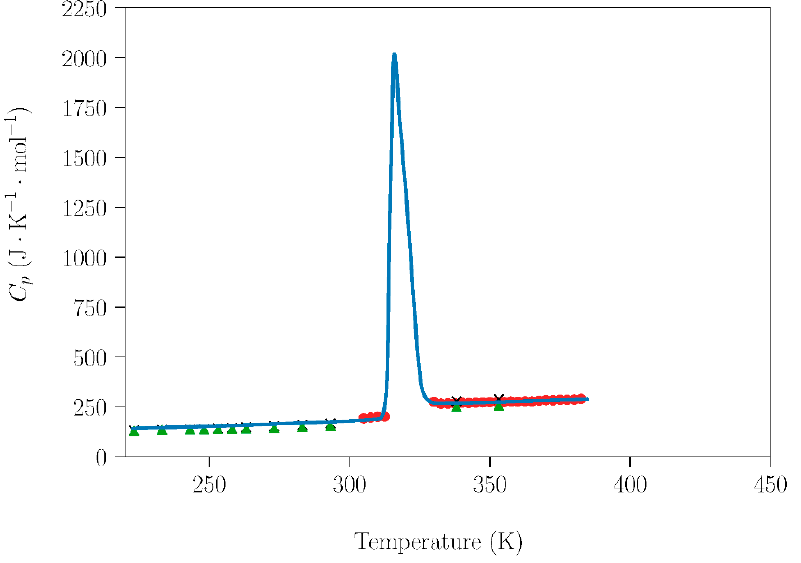
Figure 4. Dependence of molar heat capacity of NPG on temperature from 223 K up to 385 K (heating rate 2 K · min − 1 ). Blue circles are the experimental results for NPG samples handled under non-controlled environmental conditions. Red circles [31], green triangle, and black crosses [29] represent literature data for samples prepared under dry conditions in a glove box.